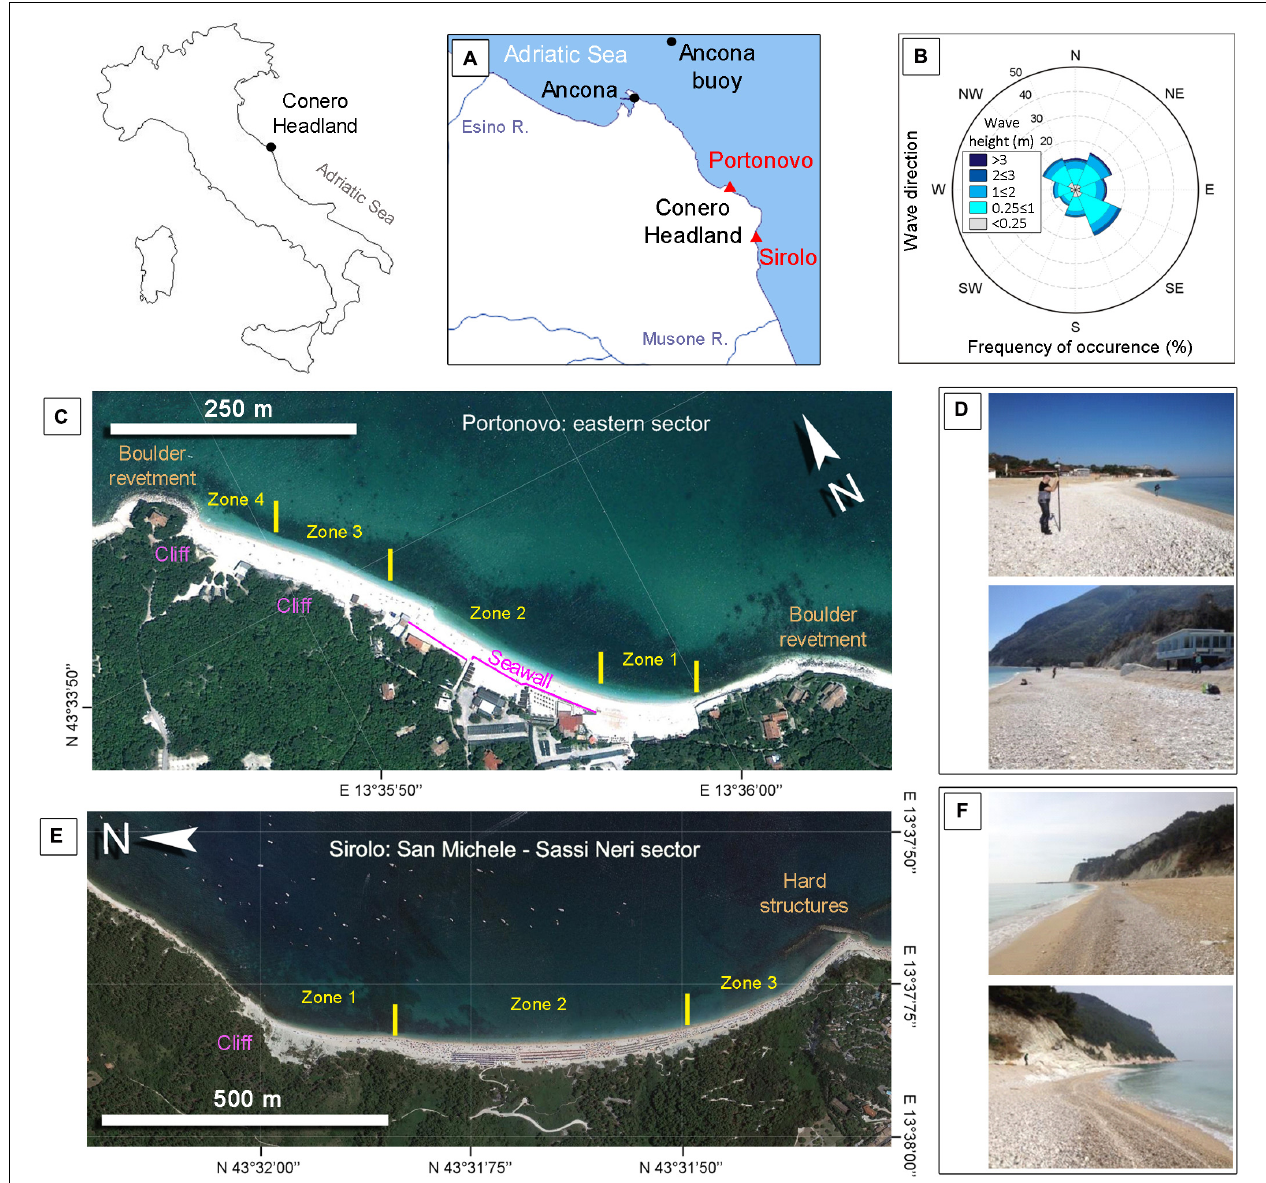
FIGURE 1 | Study sites: (A) Location; (B) Multiyear wave climate for Portonovo and Sirolo (recording period from 1999 to 2006). Wave data recorded by ISPRA buoy of Ancona (Bencivenga et al., 2012); (C) Zone subdivision in Portonovo; (D) Beach sediments in Portonovo in April 2015; (E) Zone subdivision in Sirolo; (F) Beach sediments in Sirolo in April